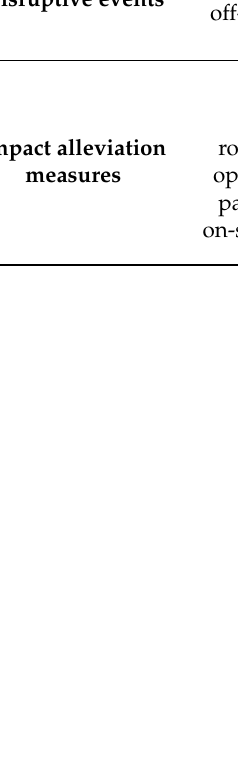
Table 2. Industrial case